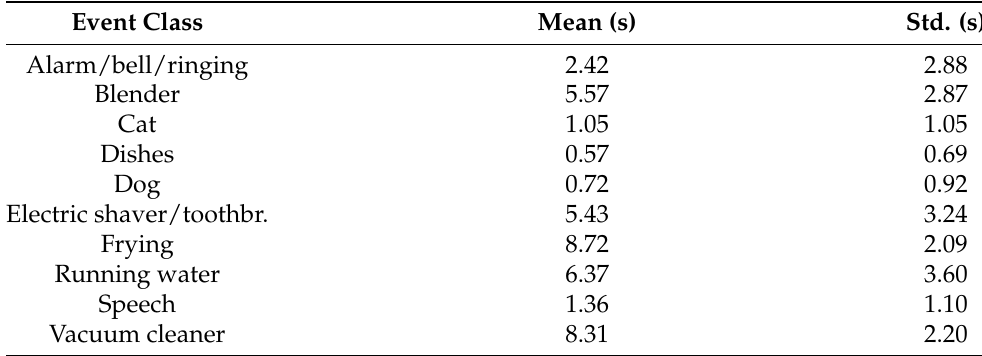
Figure 1. Block diagram showing structure of Sound Event Detection baseline system. First step is extraction of mel- spectrogram features from audio waveform. Mel-spectrograms are fed into Convolutional Recurrent Neural Network, which is composed of a convolutional stage (CNN), a recurrent stage (RNN), and an attention pooling module. Outputs of CRNN are K score sequences, one for each target category ( K = 10). Finally, to compute F 1 score, score sequences are converted into binary values using a threshold of 0.5, and then smoothed with a median filter of 0.45 s. Table 2. Mean and standard deviations of durations of sound events in DESED Public Evaluation set, computed for each target